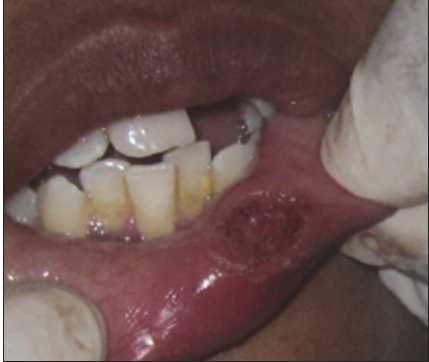
Figure 7: Photograph showing immediate postoperative day.